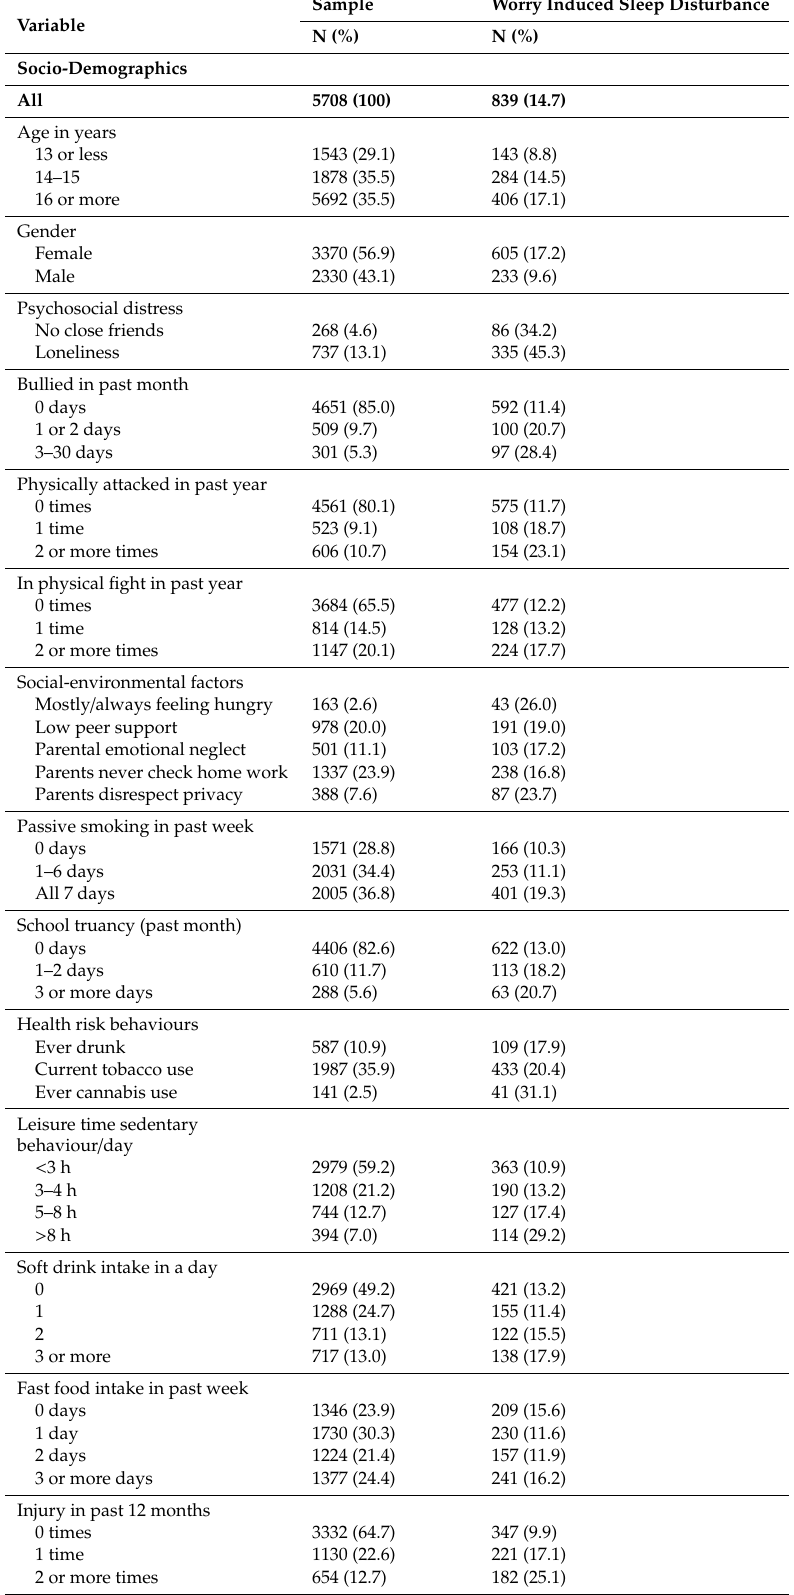
Table 1. Sample and worry-induced sleep disturbance characteristics among adolescents in